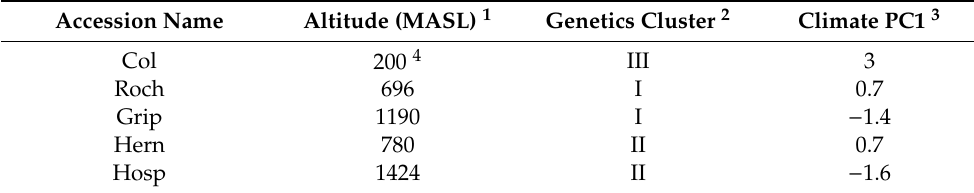
Table 1. Environmental and genetic parameters of A. thaliana populations.